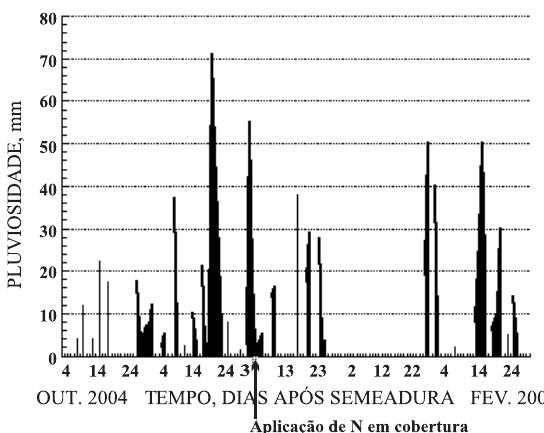
Figura 1. Pluviosidade na época da aplicação das misturas de grânulos em cobertura nitrogenada na cultura de milho, safra 2004-2005, Uberlândia